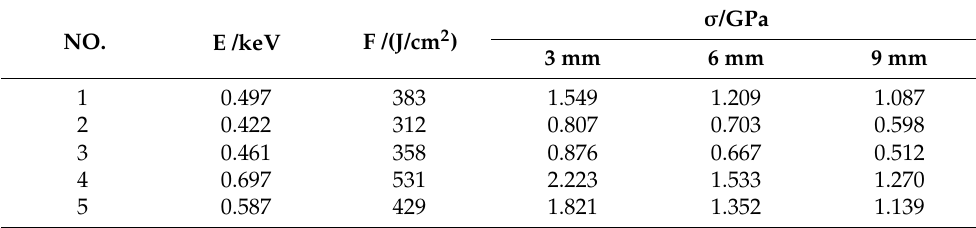
Table 1. The X-ray thermal shock wave experiment